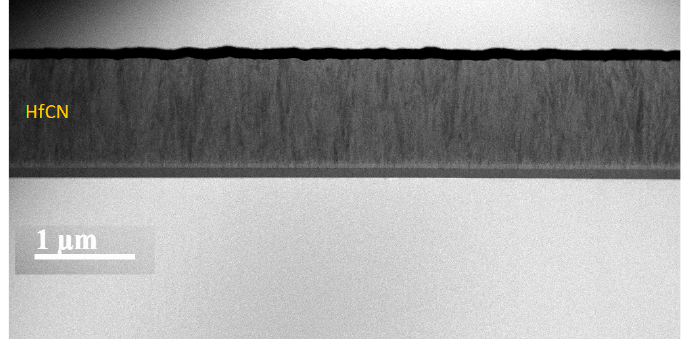
Figure 8. SEM micrograph of the cross-section for the HfCN coating deposited with a bias voltage of − 150 V.